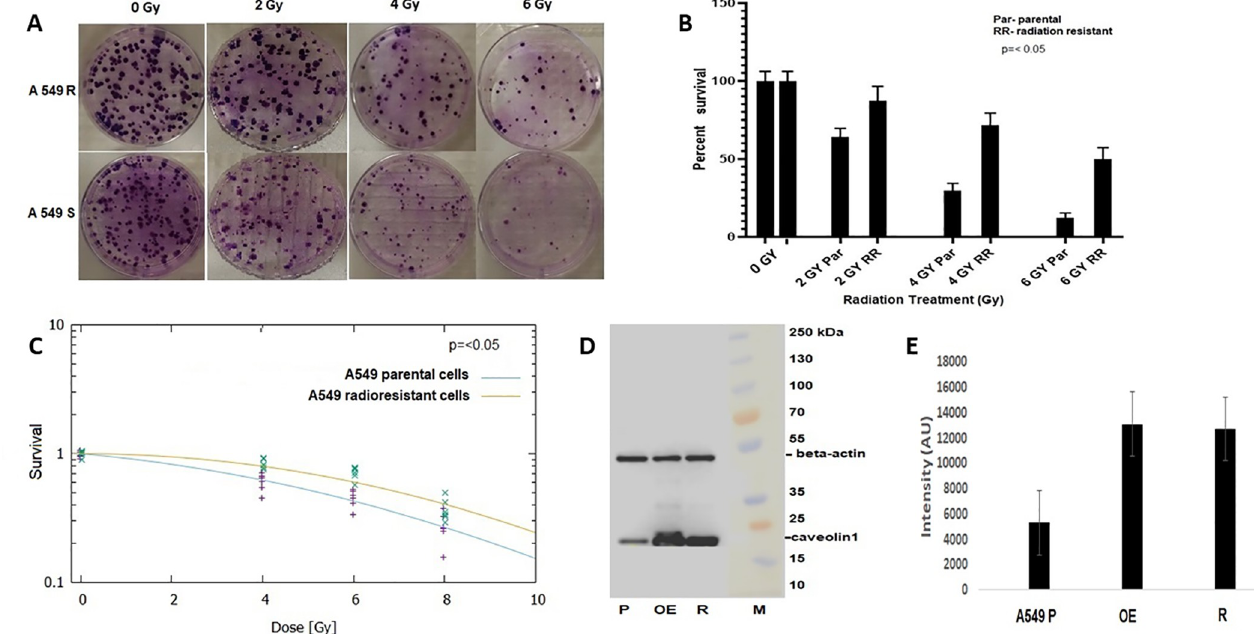
Fig 1. Over expression of caveolin-1 in radioresistant A549 lung cancer cells. (A) Clonogenic survival assay of parental and radio resistant A549 human lung cancer cell treated with 2, 4 and 6 Gy of radiation. ( B ), Percent survival of A549 parental and radioresistant cells treated with 2, 4 and 6 Gy of radiation. ( C ), Survival curve of A549 parental (blue) and radioresistant (Red) cells representing absorbed radiation dose and survival fraction using Linear-Quadratic Model. ( D ), Immunoblot analysis of Caveolin-1 (21 kDa) in the cell lysate of A549 parental (lane S), radio resistant (lane R), and CAV-1 overexpressed cells (lane OE).